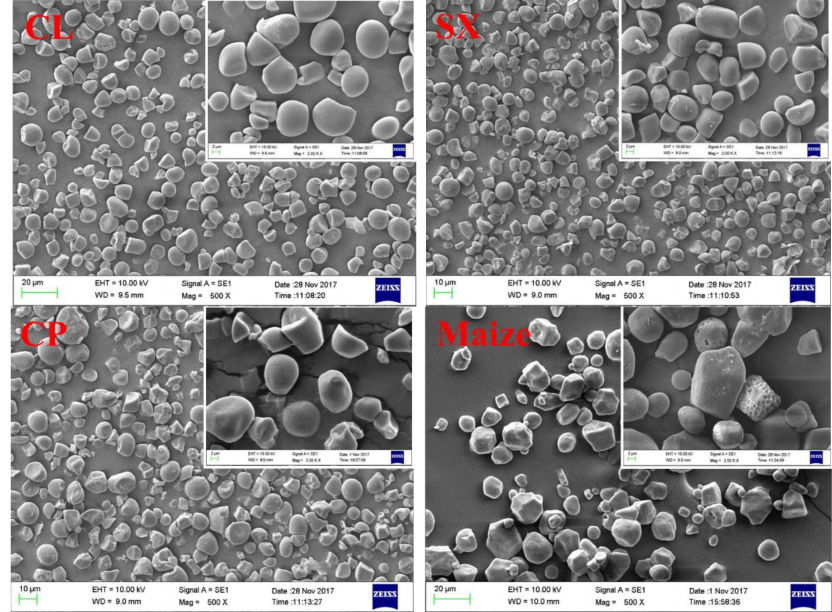
Figure 1. Scanning electron microscope images of starch from longan seeds, including Chuliang (CL), Shixia (SX), and Caopu (CP), compared with normal maize starch at 200 × and 500 × magnification.